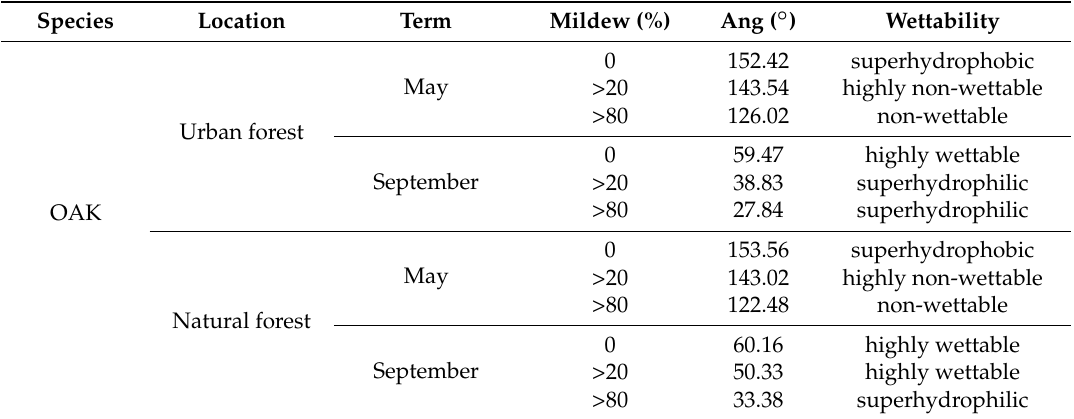
Table 5. Juxtaposition of the contact angle and the class of wettability in the analyzed plant material. Species Location Term Mildew (%) Ang ( ◦ ) Wettability May Urban forest